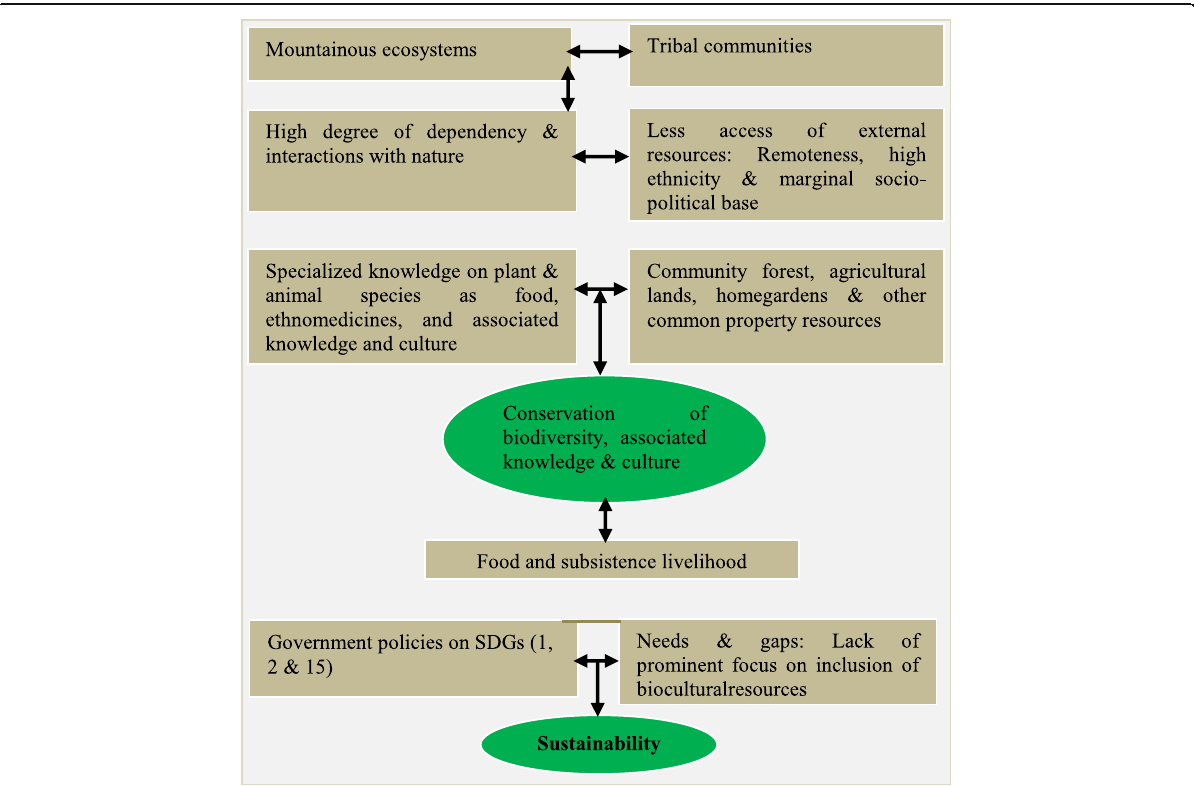
Fig. 1 Conceptual framework on biocultural resources helping to sustain food security and subsidence livelihood, and contributing to the Sustainable Development